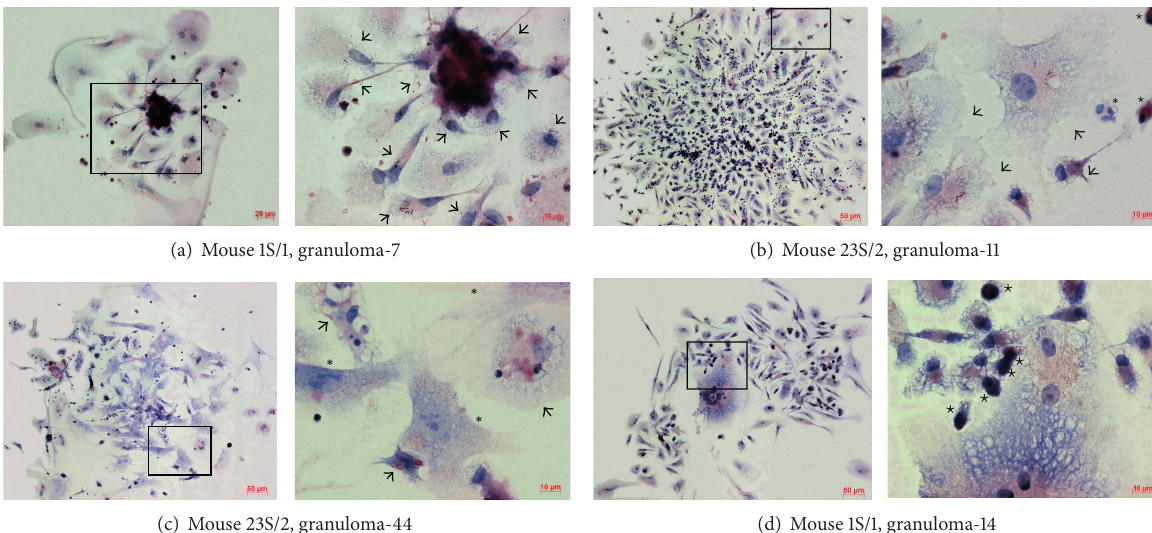
Figure 2: Granulomas from the spleens (S/) of mice that were infected with BCG vaccine in vivo for one and two months (/1 and/2, resp.) and after ex vivo culture for a few days. Ziehl-Neelsen staining for acid-fast mycobacteria. Scale bars: 50 𝜇 m ((b)-(c), left panels, (d), left panel), 20 𝜇 m ((a), left panel), 10 𝜇 m ((a)–(c), right panels, (d), right panel). Granulomas with different cell types: pictures ((a)–(c), right panels, (d), right panel) are enlarged images of the areas defined by black boxes in pictures ((a)–(c), left panels, (d), left panel), respectively. ((a)–(c)) Macrophages with BCG-mycobacteria are indicated by black arrows. ((b), (d)) Dendritic cells are indicated by black stars. ((b)-(c)) A neutrophil and fibroblasts are indicated by black snowflakes, respectively. The other cells are macrophages without BCG mycobacteria, lymphocytes, and erythrocytes. (a) Macrophages that have migrated from a granuloma. (b)–(d) The monolayer cultures of cells migrated from individual granulomas. (b)-(c) Granulomas with an increased number of macrophages and fibroblasts, respectively. (d) Langhans giant cell in a granuloma. The fusion of macrophage membranes and entry of new macrophage nuclei to the nuclear aggregates of Langhans giant cell.